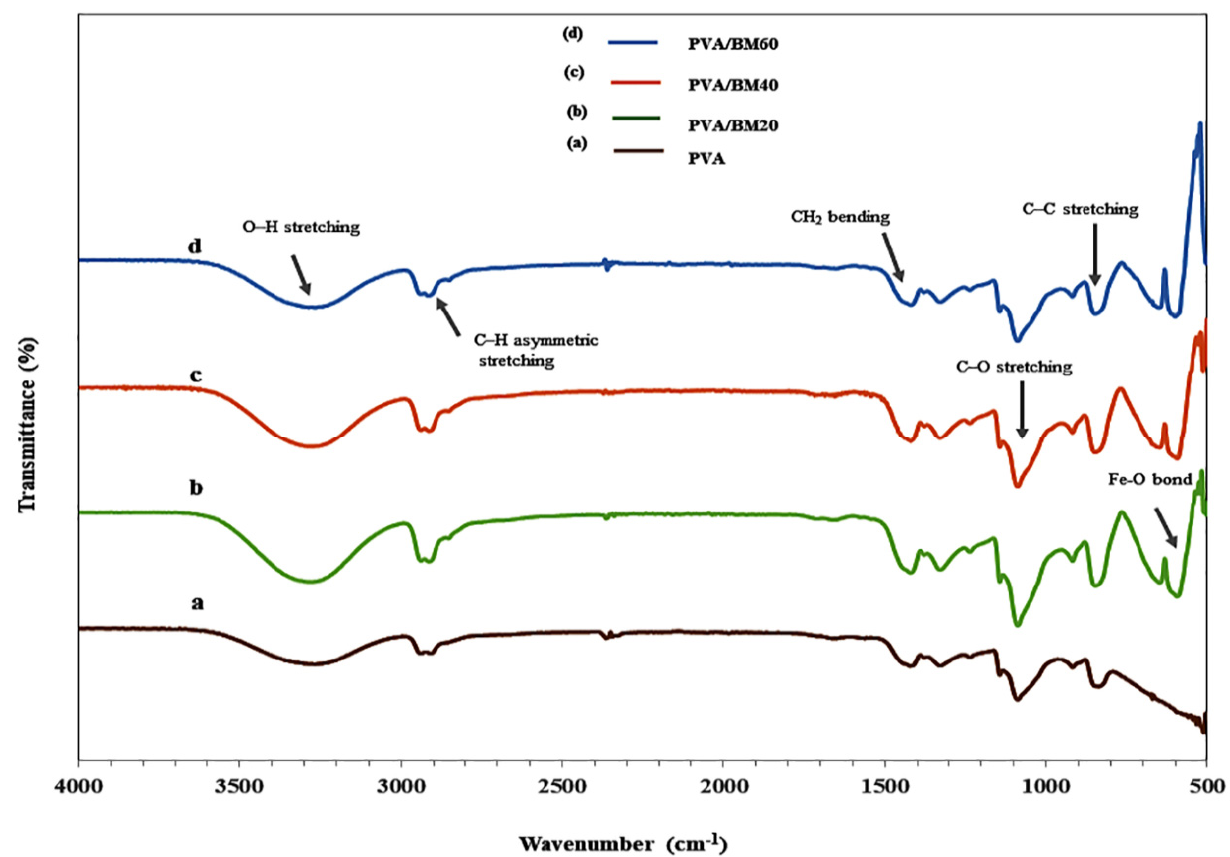
Figure 4. X-ray diffraction pattern of ( a ) PVA, ( b ) PVA/BM20, ( c ) PVA/BM40 and ( d ) PVA/BM60 composite films.